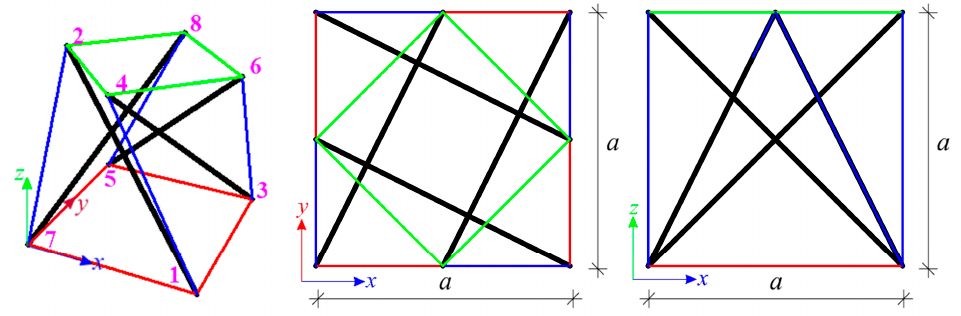
Figure 6. Geometry of the single modified Quartex